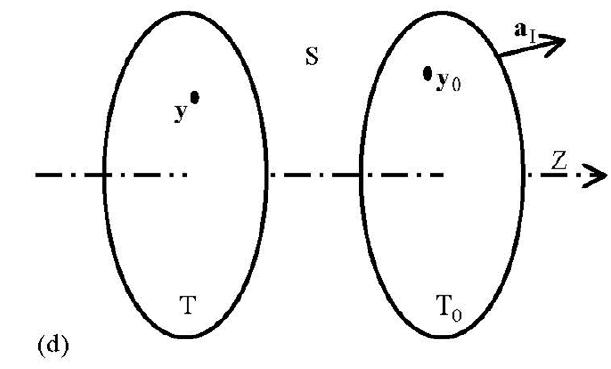
Figure 1 Longitudinal axis Z and entrance and exit planes (T with or without a subscript) of four dioptric systems S used in the text. None of the elements of the systems is shown. In (a) object point O has transverse position y located on the entrance plane T O emerges from S at a point with transverse position y on exit plane T. In (b) a segment of a ray with inclination a a distant object point O is incident onto the entrance plane T of S. In (c) a ray is incident onto S at transverse position y and emerges at image point I at position y ray incident at y emerges at y distant image point